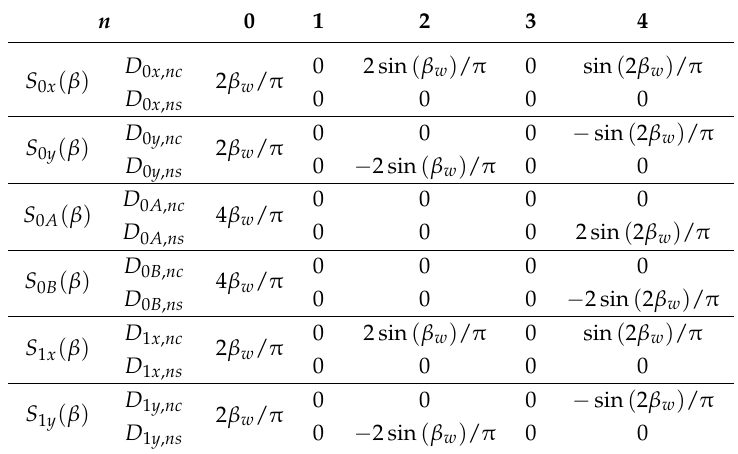
Table 5. Fourier coefficients of S i ( β ) for the single-ended electrode arrangement of MHRs.